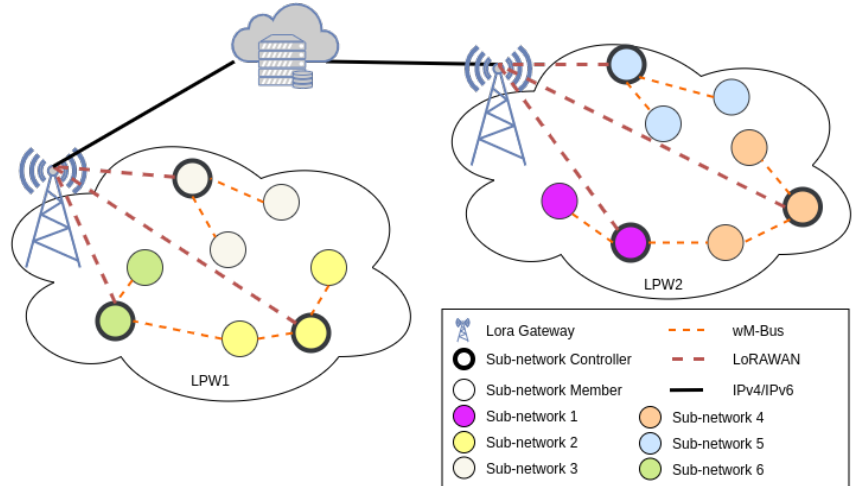
Figure 3. A hierarchical network architecture based on LPWAN and